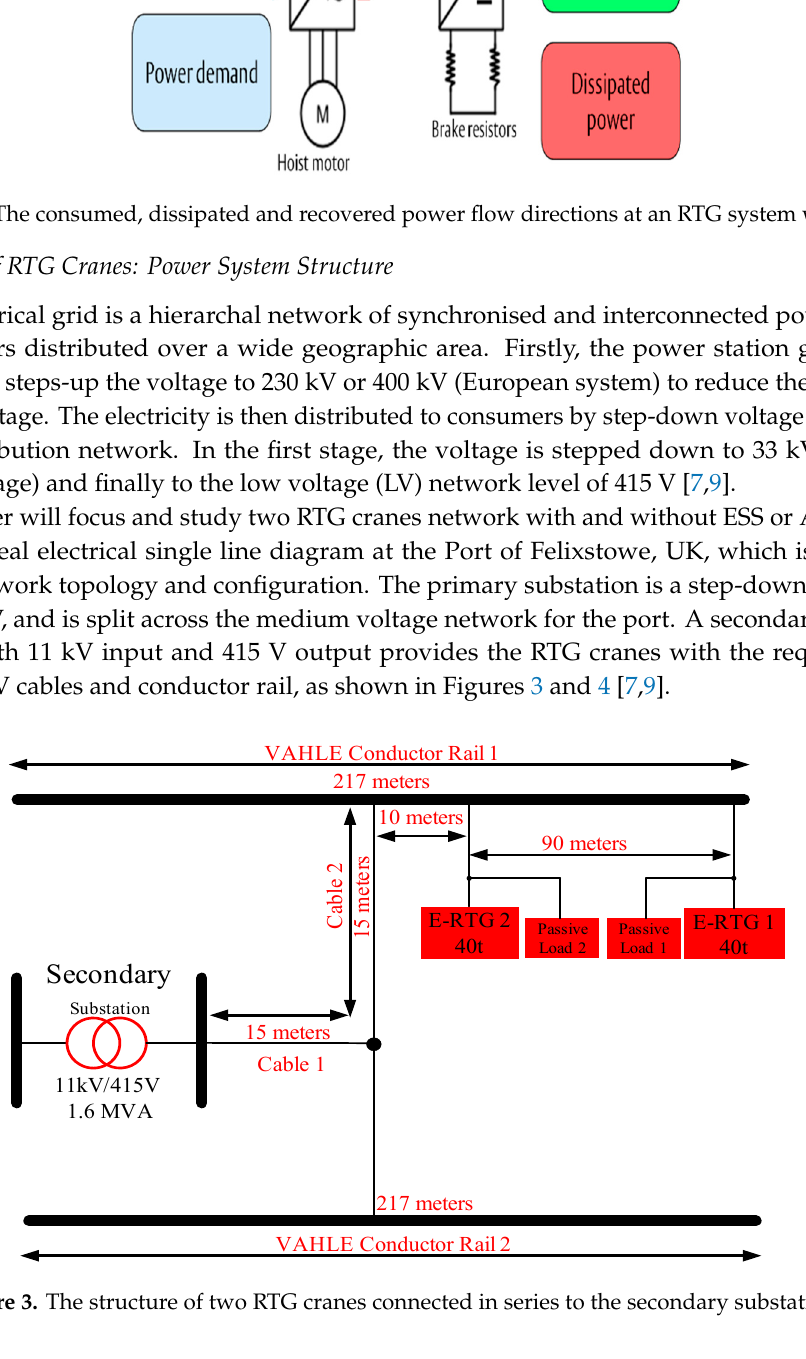
Figure 3. The structure of two RTG cranes connected in series to the secondary substation.